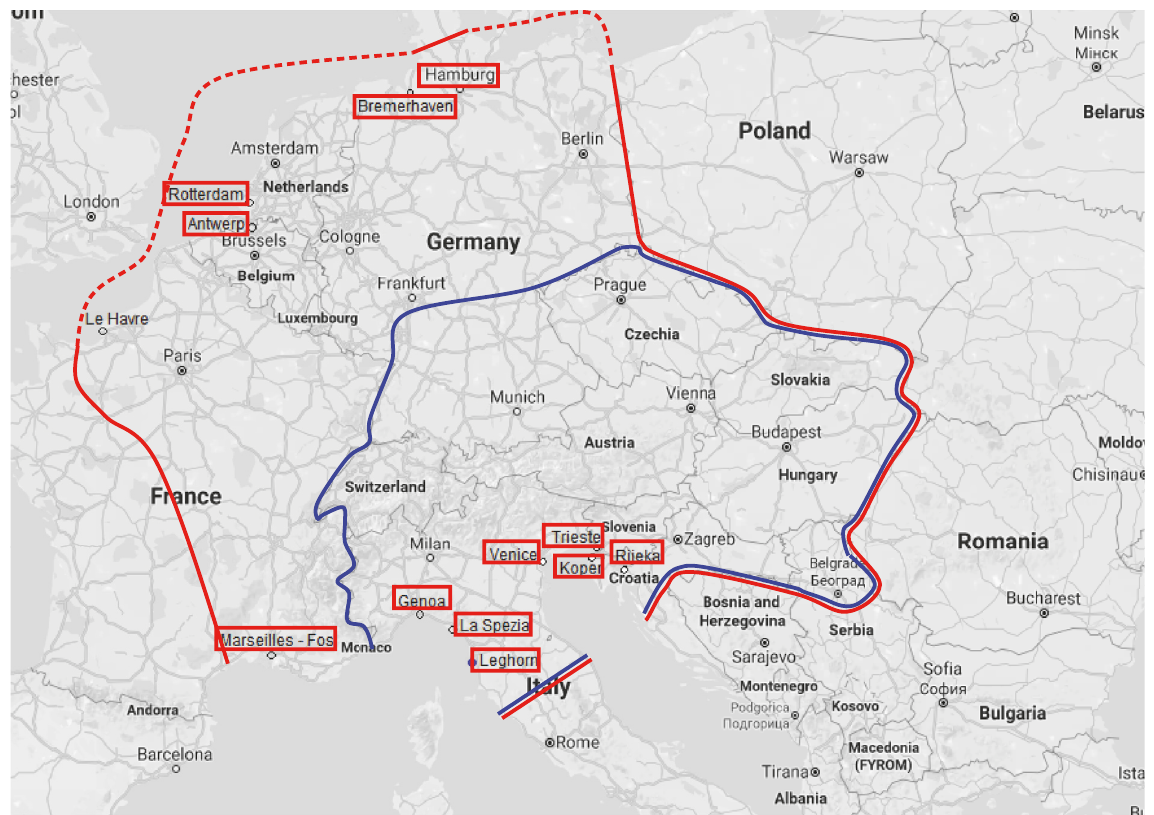
Figure 1: Potential hinterland (circled in blue) of the future container terminal of Leghorn and the European region whose rail network has been modelized (circled in